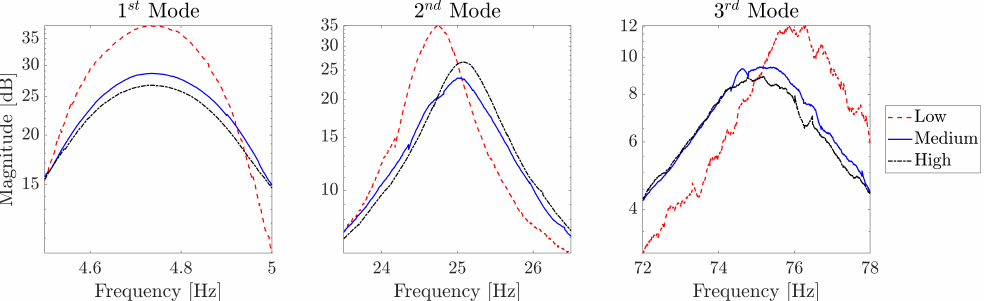
Figure 11. Twin spar: comparison of the FRFs of channel #4L for the three input scenarios near